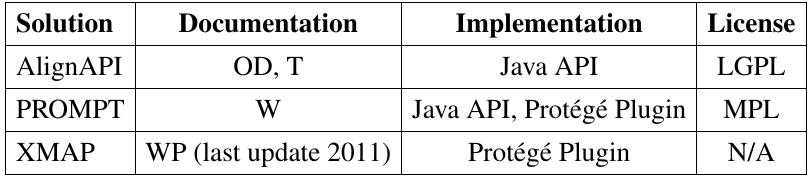
Table 1. Documentation, Implementation, and License